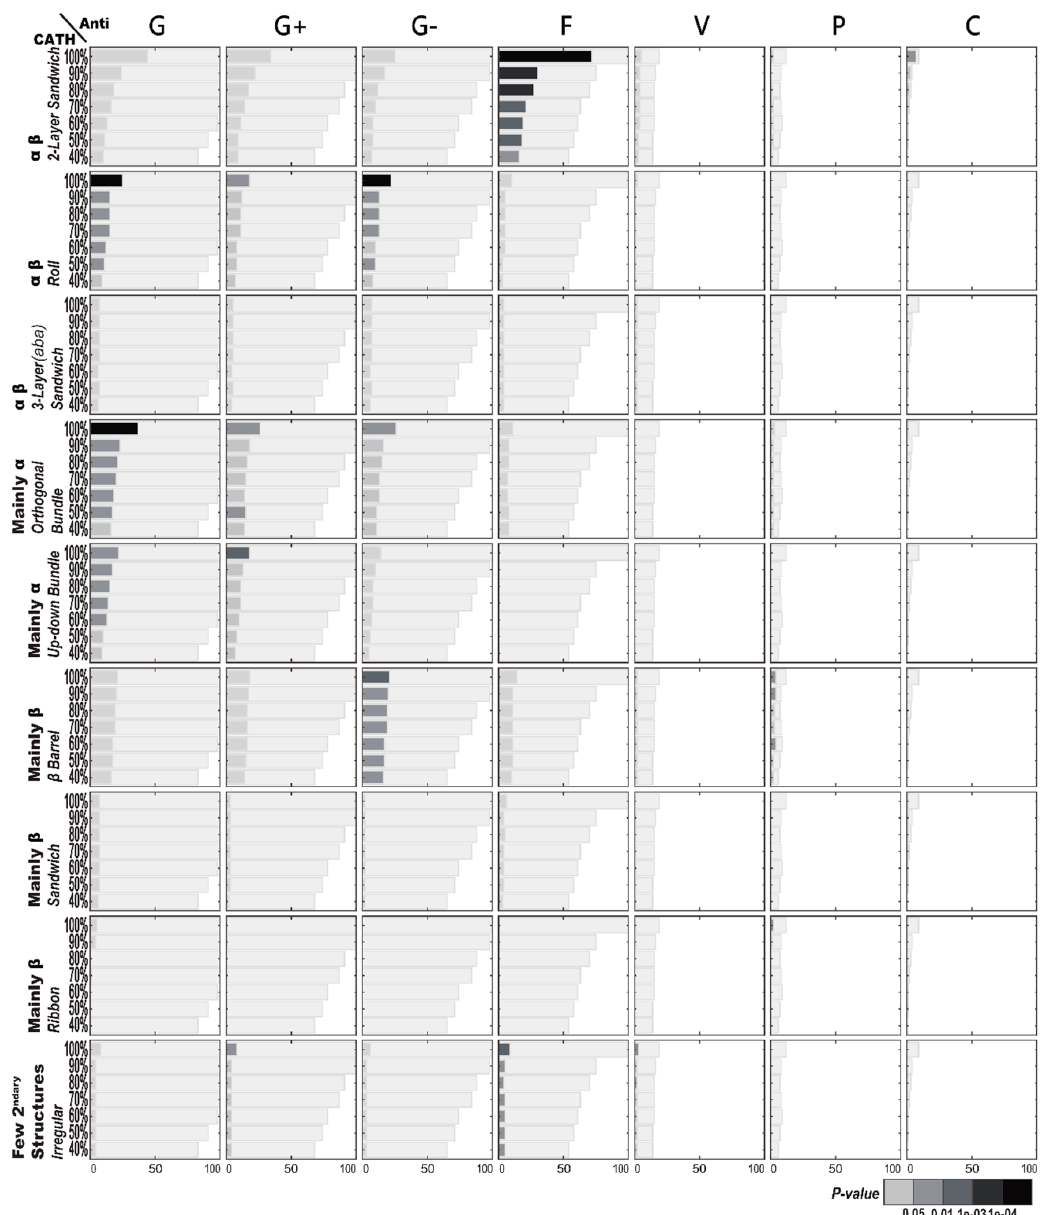
Figure 4. CATH structural enrichment analysis of antimicrobial peptides (AMPs) with respect to their functions. The X -axis and Y -axis are, respectively, the number of AMP sequences and the percentage of sequence identity. The bar in light gray indicates the potential maximum number of AMP sequences with the specific structure. Abbreviations: C, anticancer; F, antifungal; G, antibacterial; G+, anti-Gram+; G-, anti-Gram-; P, antiparasitic; V, antiviral.